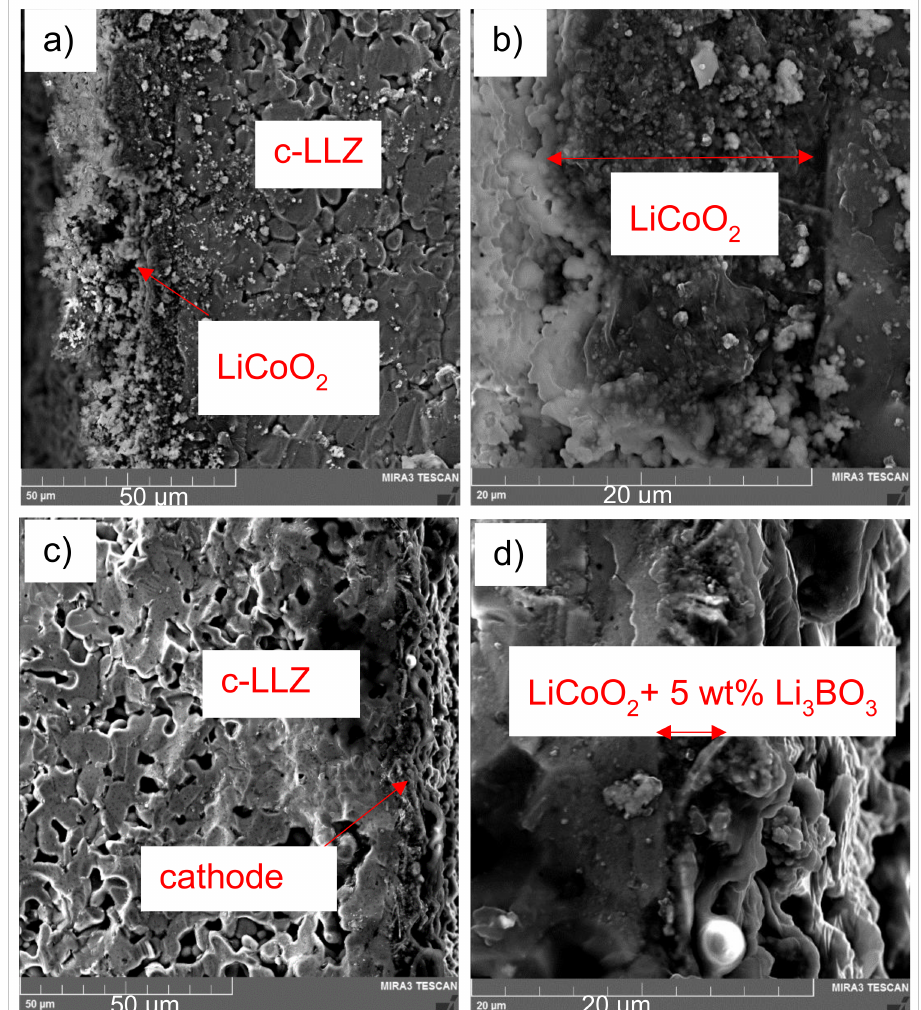
Figure 6. SEM images of the cross-section of LiCoO 2 |c-LLZ ( a , b ) and LiCoO 2 + 5 wt% Li 3 BO 3 |c-LLZ ( c , d ) half-cells, after heating at 720 ◦